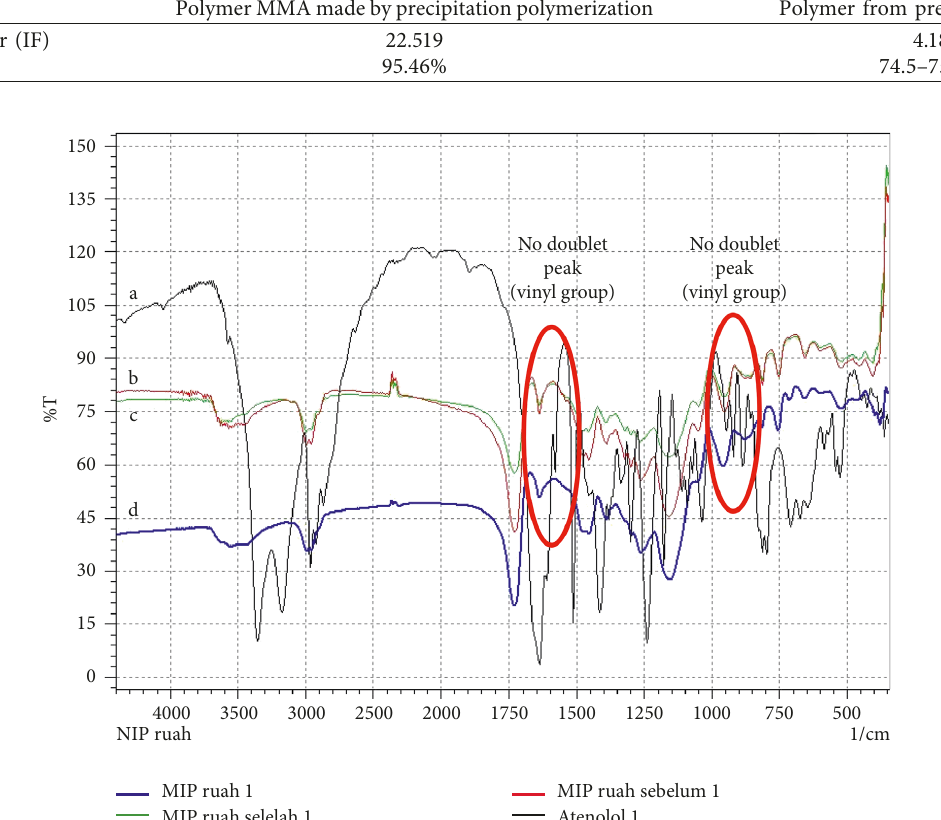
Figure 4: FTIR spectrum: (a) atenolol; (b) MIP by bulk before extraction; (c) MIP by bulk after extraction; (d) NIP by bulk.